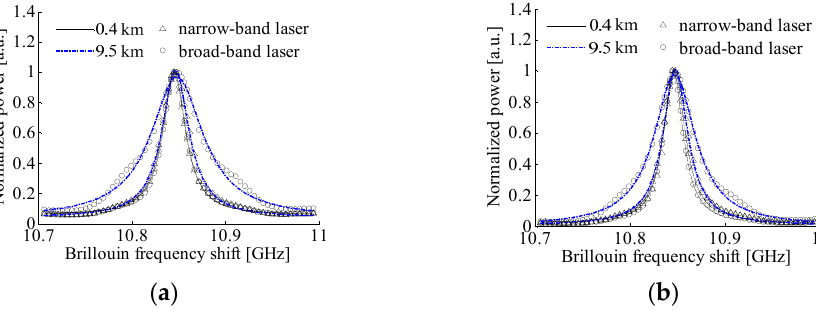
Figure 4. Brillouin spectra of 0.4 km and 9.5 km long fibers with different lasers: ( a ) local heterodyne detection and ( b ) self-heterodyne detection.